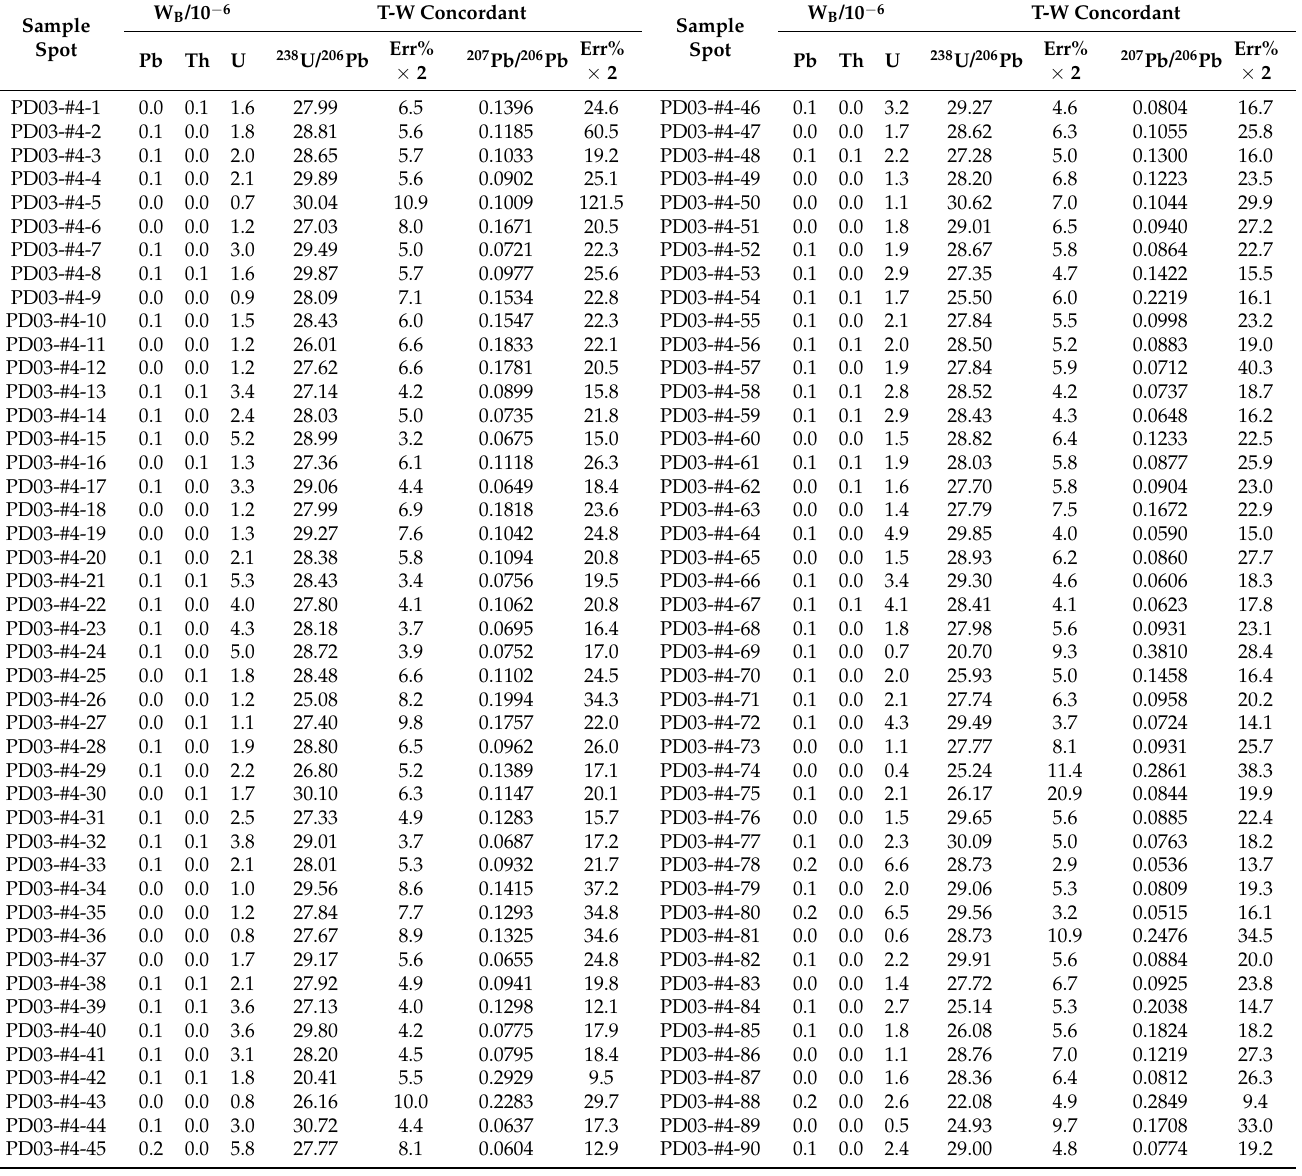
Table 2. LA-ICP-MS U–Pb isotopic data for cassiterite in the Wuzhutang granite from the Xuebaoding mining